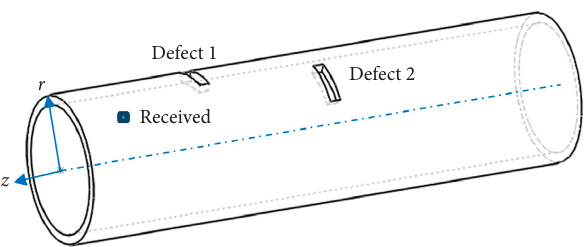
Figure 15: Double-defect model diagram for different circum- ferential positions.